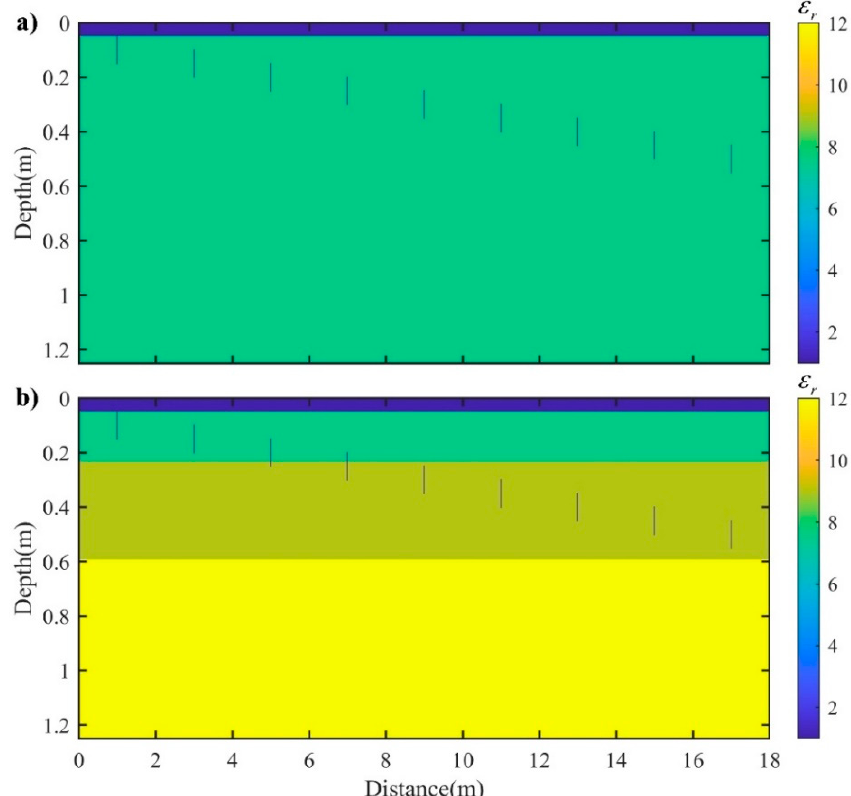
Figure 4. ( a ) Model 5, 2 D homogeneous model with cracks at different buried depths, and ( b ) Model 6, 2 D layered homogeneous model with cracks at different buried depths.